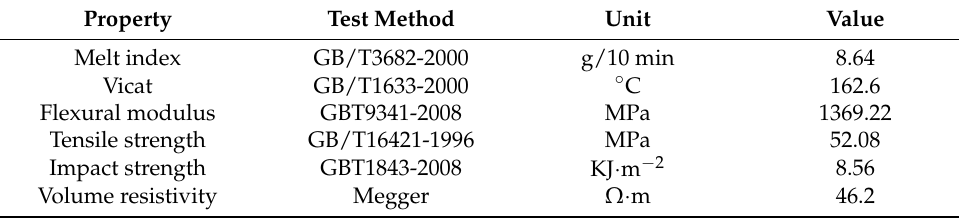
Figure 1. MWCNT/PA12 composites preparation process. Table 2. Properties of 10 wt.% MWCNT/PA12 composites.